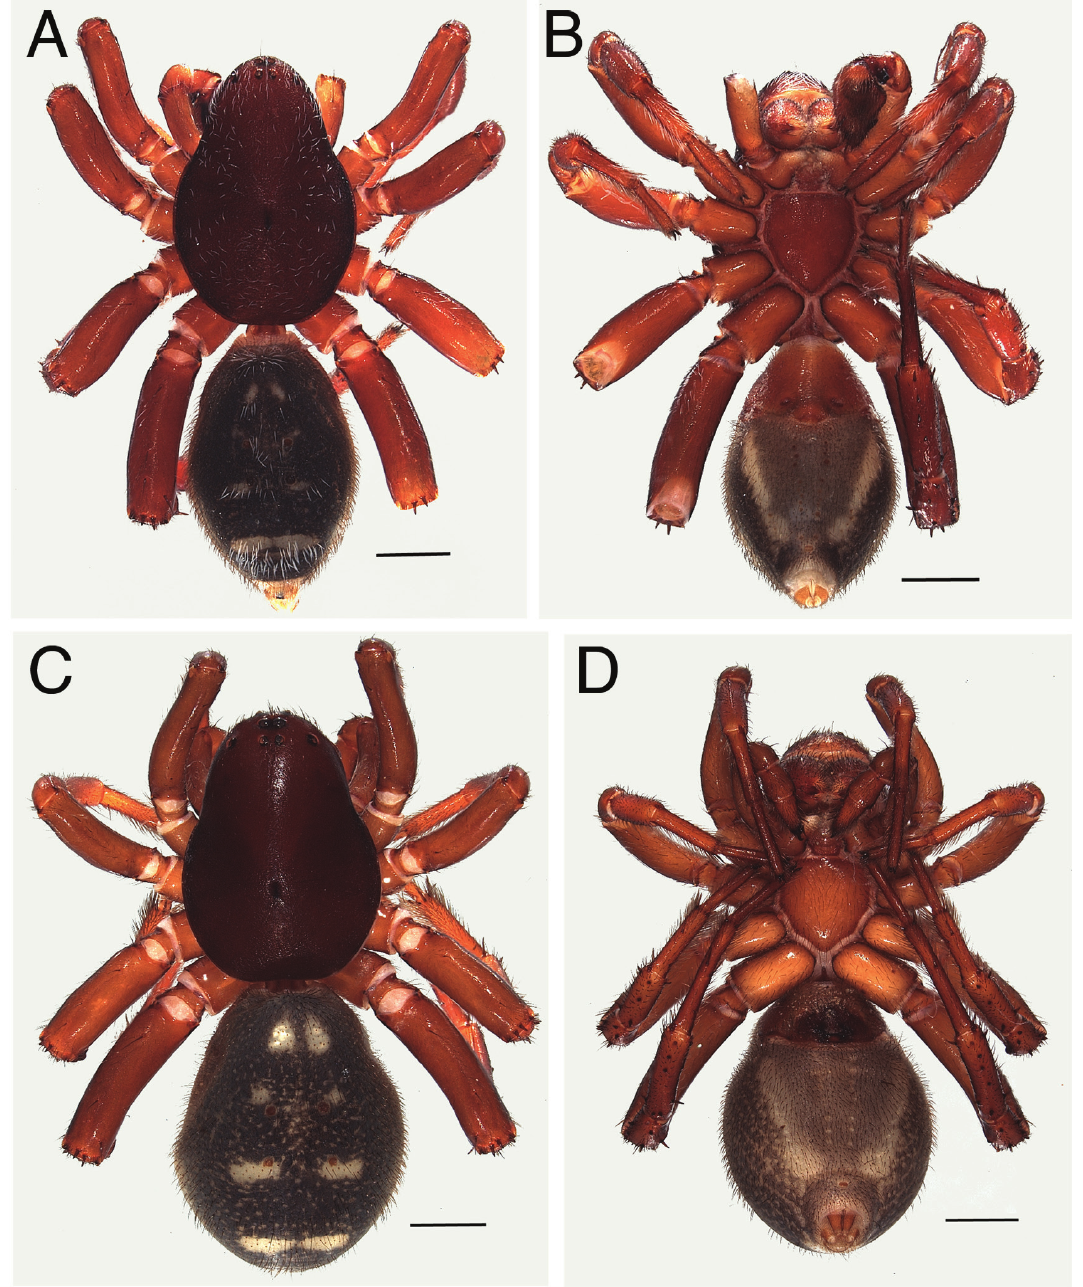
Fig. 8. Palindroma avonova gen. et sp. nov. A–B. Holotype, ♂. C–D. ♀ from Maringa Forest. A . ♂, habitus, dorsal view. B . Idem, ventral view. C . ♀, habitus, dorsal view. D . Idem, ventral view. Scale bars = 1